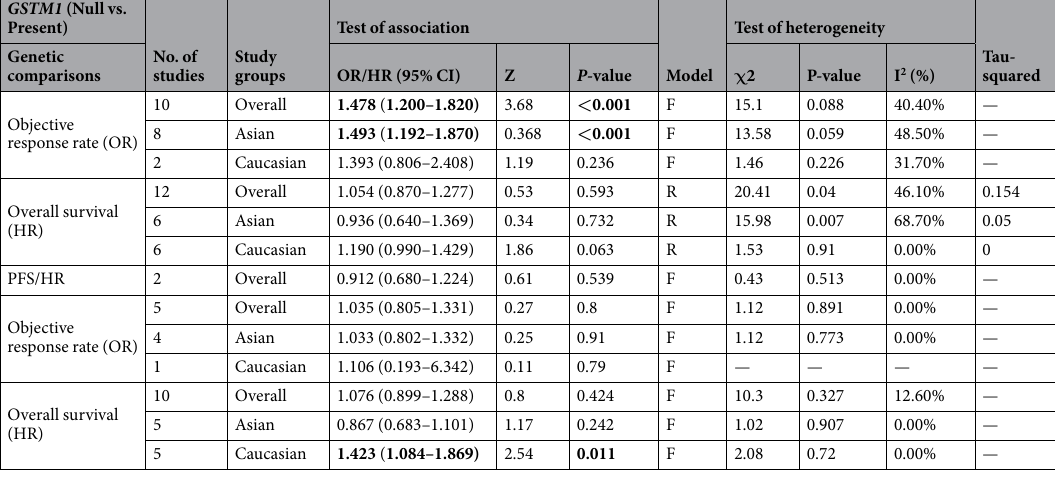
Table 5. Meta-analysis of the association between GSTM1 and GSTT1 polymorphisms and platinum-based chemotherapy in objective response rate, overall survival for NSCLC patients. OR, odds ratio; HR: hazard ratio; CI, confidence interval; vs., versus; F, fixed effect model; R, random effect